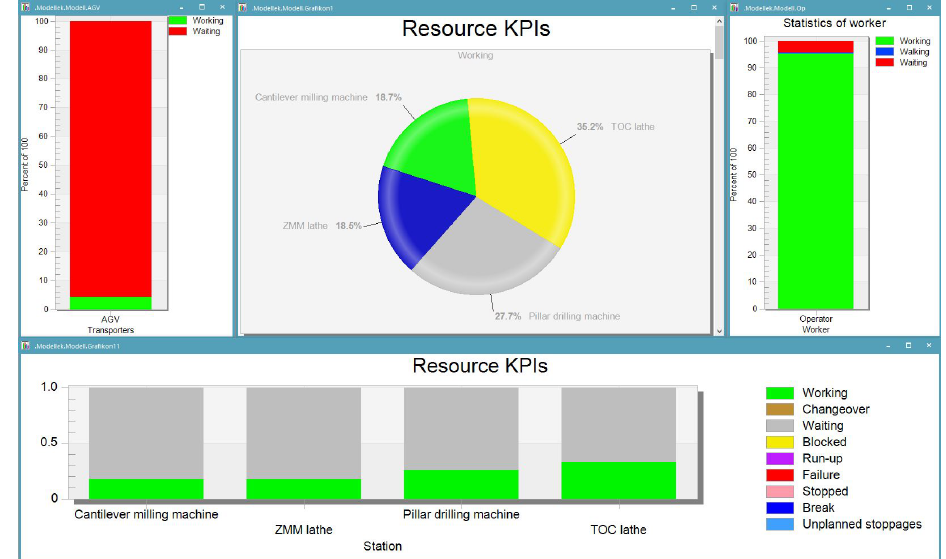
Figure 12. Example for a dashboard of production